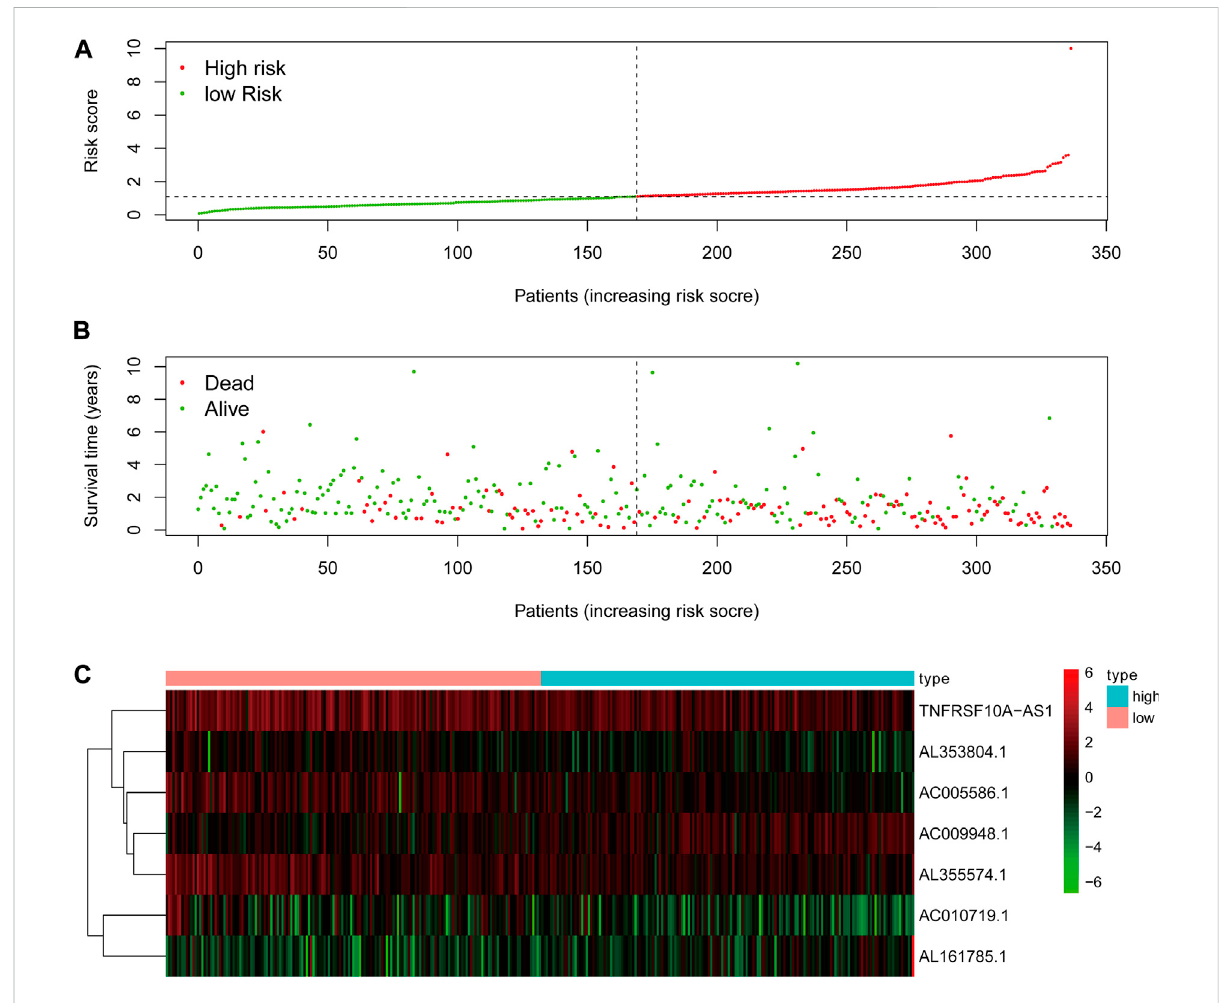
FIGURE 5 The analysis of glycolysis-related lncRNA signature for patients in STAD. (A) The risk score between the high-risk group and low-risk group. (B) Thesurvivalstatusofthehigh-riskgroupandthelow-risk groupinSTAD patients. (C) Heatmapofsevenglycolysis-relatedlncRNAs ’ expression.The color from green to red reveals a rising tendency from low to high expression